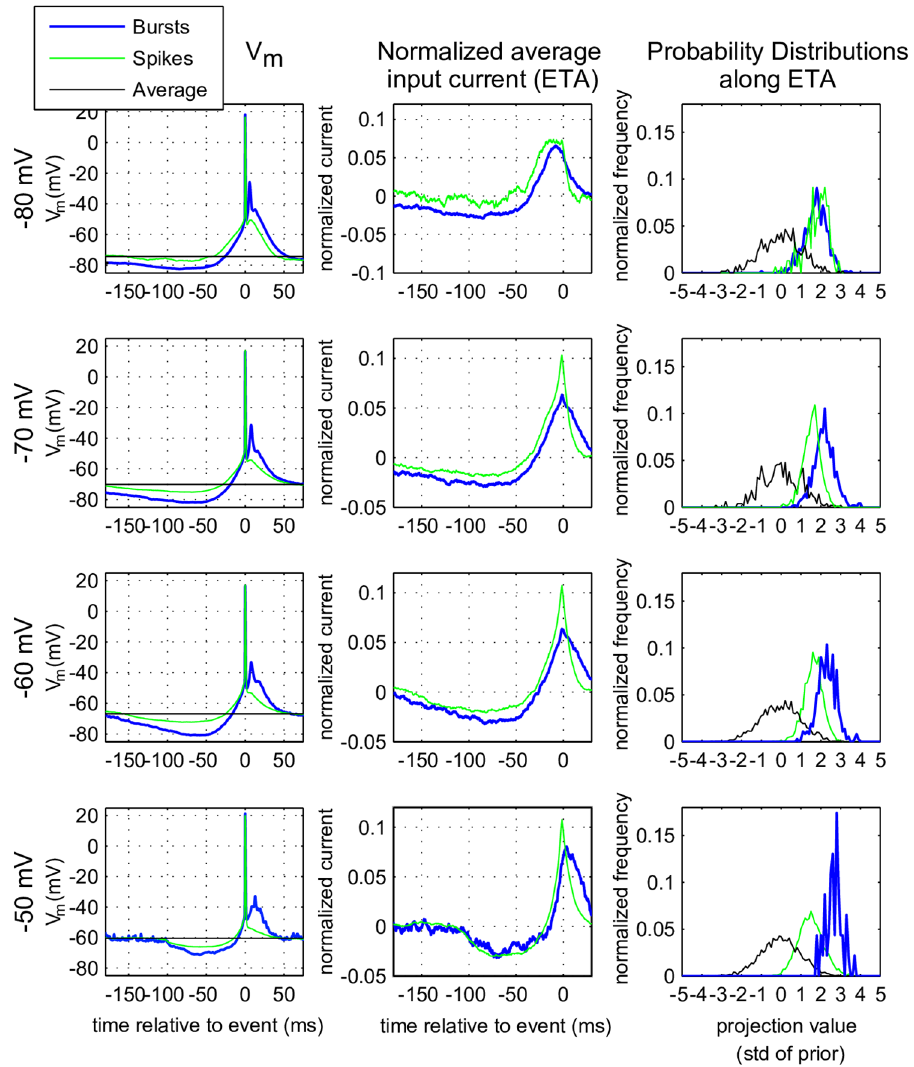
Fig 6. Event Triggering Average (ETA) of membrane potential and injected current. Left column: ETA of the membrane potential 200 ms preceeding single spikes (green),aligned at t = 0, or bursts (blue). The peak of the spike (or first spike in the burst) was used as trigger; this implies perfect coincidence of isolated spike and first spike in the burst; later spikes in the burst tend to average out. The horizontal black lines indicate the mean value of the subthreshold membrane potential calculated from the entire trial. Middle column: ETA of the input current (mean value substracted and normalized with the L2 norm) using the triggerpoints from the voltage (peak of the spikes, left column). Right column: probability distributions of a convolution of the normalized ETA with event-triggered (blue/green lines) or with a random input (black line, also called the prior). Rows indicate membrane states.